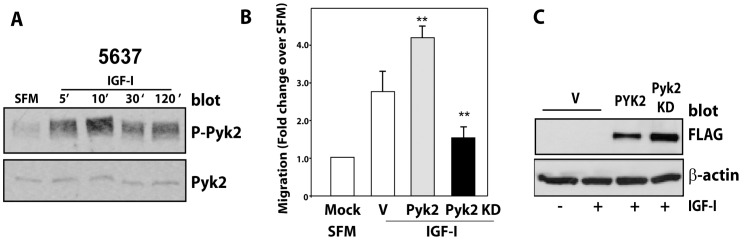
IGF-I-activated Pyk2 is critical for IGF-IR-dependent motility of invasive urothelial cancer cells.(A) Serum-starved 5637 cells were stimulated with 50 ng/ml of IGF-I for the indicated time points. Pyk2 phosphorylation was detected by immunoblot using anti-phospho-Pyk2 (Tyr402) antibodies, while total Pyk2 protein level was assessed using anti-Pyk2 polyclonal antibodies. Blot is representative of two independent experiments. (B) Migration of 5637 cells transiently transfected with either Flag-tagged wild type (PYK2 WT) or a dominant negative (KD PYK2) Pyk2 proteins was assessed after 16 hours of IGF-I stimulation. Values are expressed as fold change over SFM and represent mean ± SD. ** P<0.01. (C) Expression levels of transiently transfected Pyk2 proteins were assessed by immunoblot with anti-flag M2 antibodies. Blot is representative of two independent experiments.